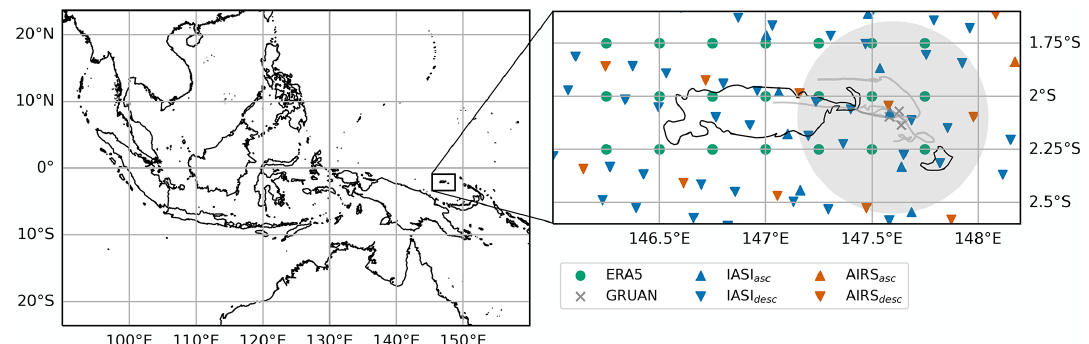
Figure 1. Maps show the geographical location of Manus Island and spatial sampling over 1d (28 March 2012) of the four investigated datasets. The satellite data are split into ascending and descending node data. Radiosonde pathways are shown as lines. Their mean position is indicated by grey crosses that are used as collocation locations. The transparent grey circle visually indicates the collocation radius of